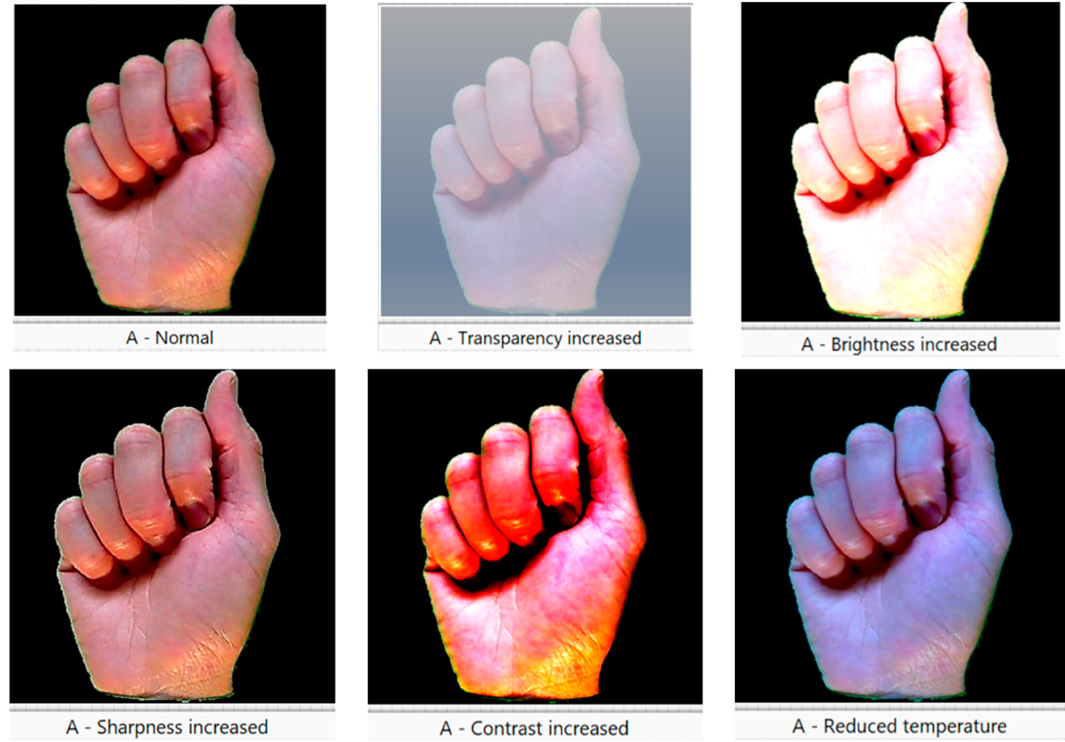
Figure 9. Hand gesture dataset for experiment 1.